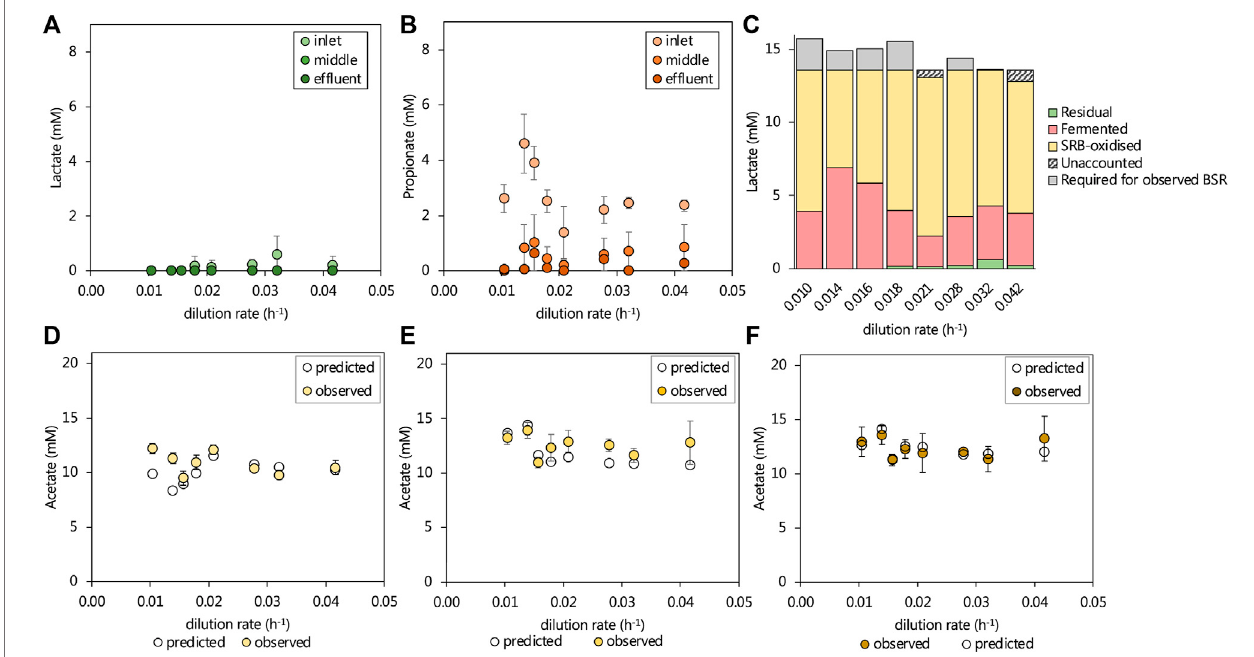
FIGURE 3 | The observed steady-state residual (A) lactate and (B) propionate leaving the three zones of the lactate UAPBR at increasing dilution rates. The (C) amountoflactate fermented(Eq.5)wasestimated basedontheresidualpropionateconcentrationandtheremainderofavailablelactatewasassumedtobeconsumed by SRM and veri fi ed based on the degree of sulfate reduction. Where more sulfate reduction occurred than could be stoichiometrically accounted for by incomplete lactate oxidation by SRM, this was indicated as lactate “ required for observed BSR ” . The observed and predicted acetate concentrations leaving the (D) inlet (E) middle and (F) ef fl uent zones of the lactate-supplemented UAPBR are shown. The predicted acetate concentrations were calculated based on the assumptions described in text and that the oxidation of0.4 g/L yeast extract led to the generation of 268 mg/L acetate, asdescribed in Hessler et al. (2021). Error bars represent one standard deviation from the mean ( n >